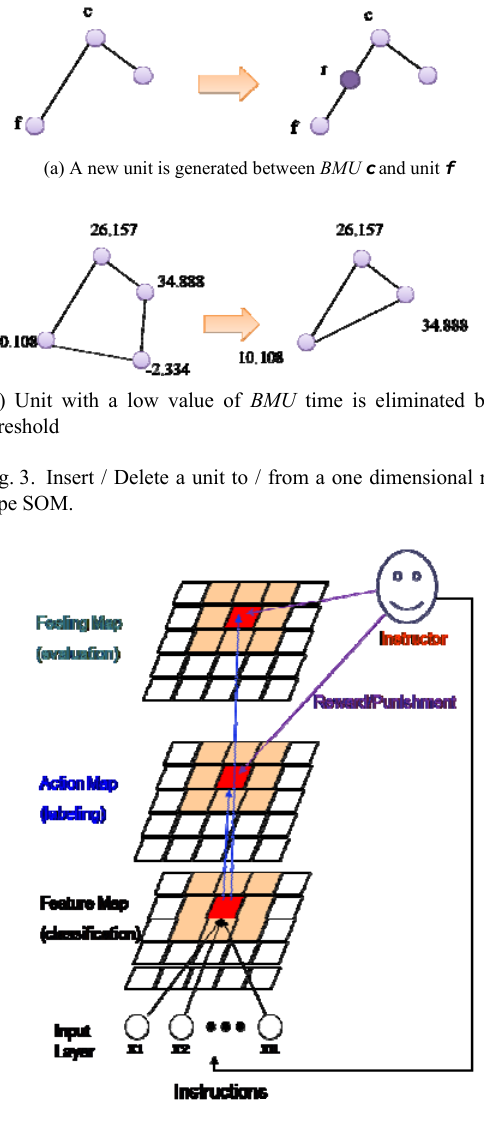
Fig. 4. A hand shape instruction learning